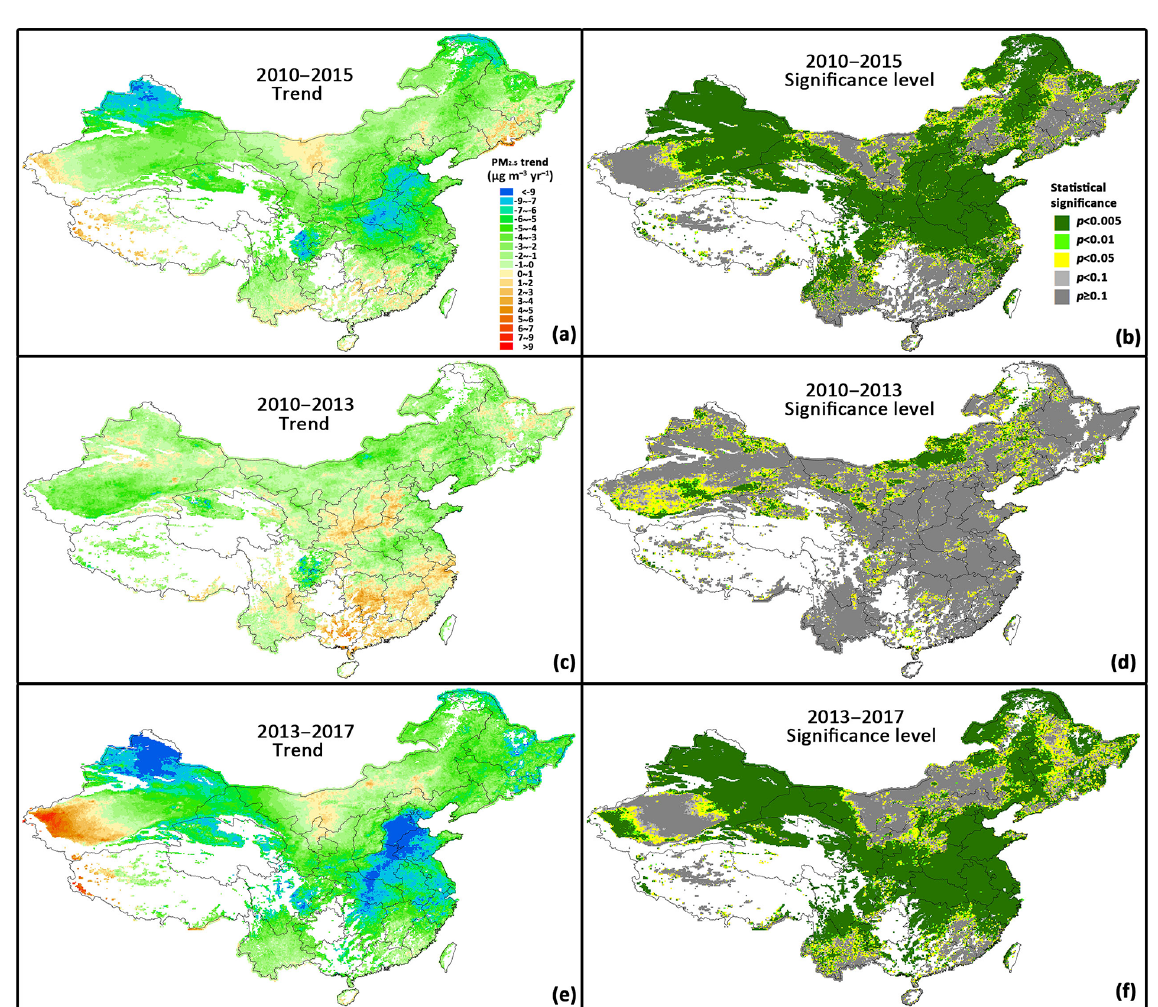
Figure 8. Spatial distributions of PM 2 . 5 trends and significance levels in China from 2010 to